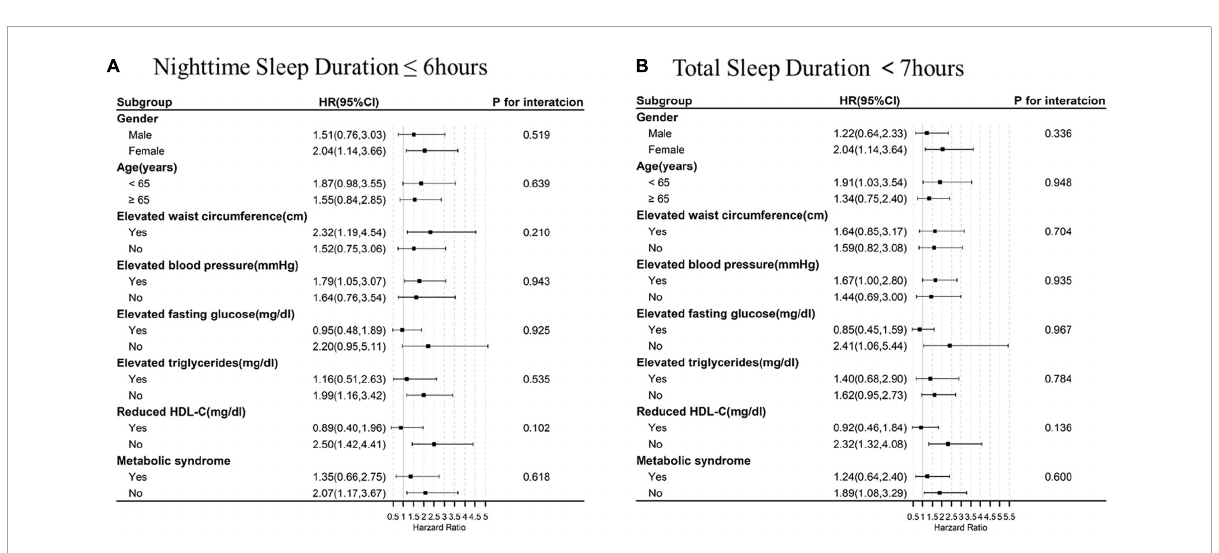
FIGURE4 Sleep duration and incident stroke risk, stratified by baseline characteristics and metabolic syndrome. All hazard ratios were calculated with (A) night sleep duration > 6 h/night and (B) total sleep duration ≥ 7 h/day as the reference groups, with models adjusted for gender, age, educational level, marital status, area of residence, behaviors including smoking, drinking, and physical activity, along with additional adjustment for self-reported diagnosis of stroke, dyslipidemia, hypertension, diabetes or high blood sugar, BMI, waist circumference, triglycerides, HDL-C, systolic and diastolic blood pressure, fasting plasma glucose, and HbA1c levels. Each group adjusted for the other covariates except itself. HR, hazard ratio; CI, confidence